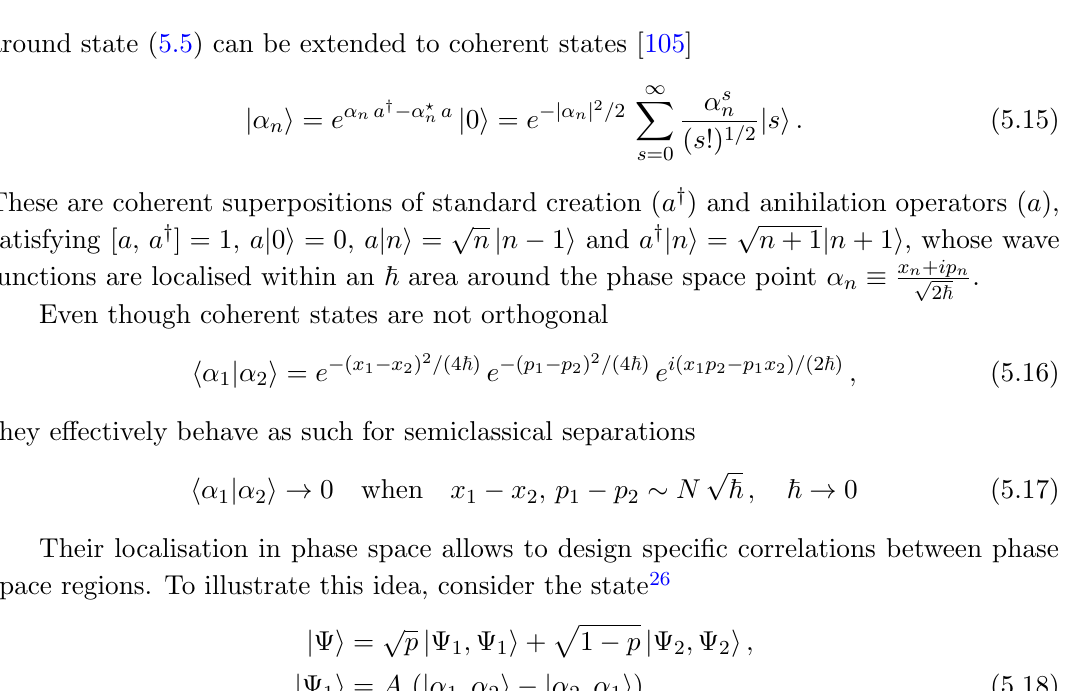
Figure 19 . Two entangled distributions of giant gravitons located at r L = 0 and r R = 0, spread over the localised regions [ (cid:18) 0 ; (cid:25)= 2] in two di(cid:11)erent spheres along (cid:18) L and (cid:18) R connected through the correlations encoded in the phase space formulation of their joint quantum mechanical